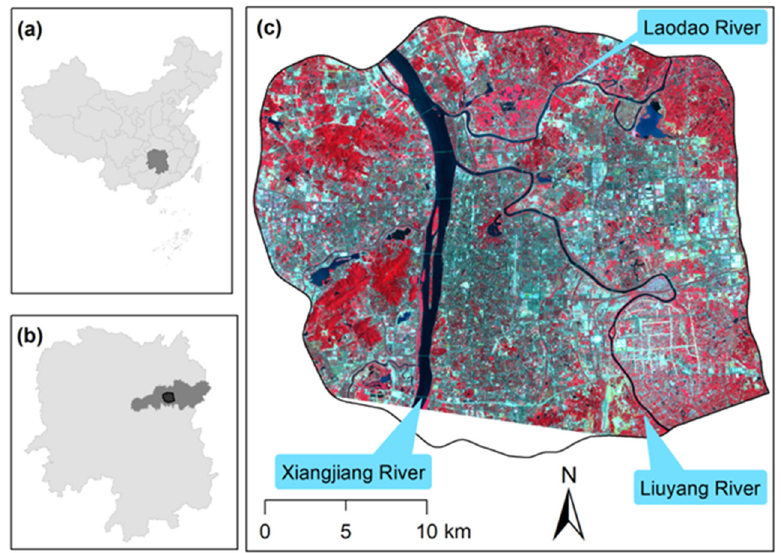
Figure 2. Study area: location of Hunan province in China ( a ), location of the study area in Changsha City and Hunan province ( b ), and Landsat image of the study area in 2018 ( c ).